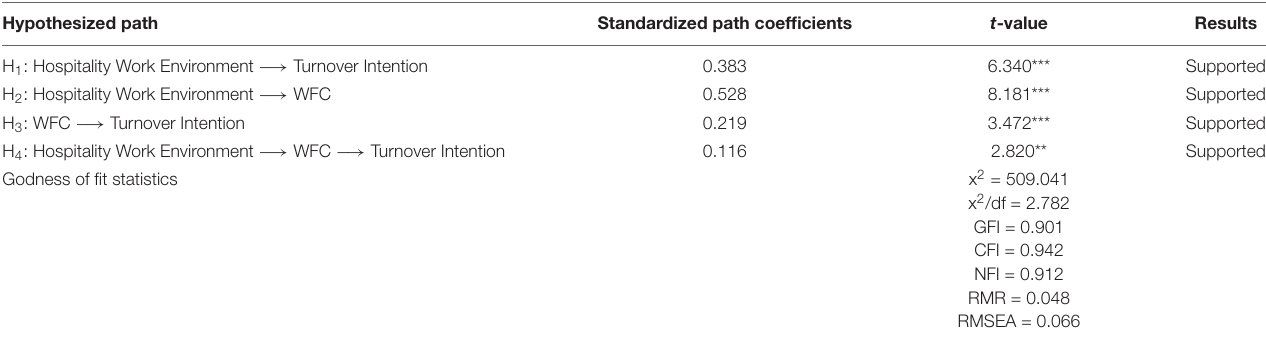
TABLE 3 | Structural parameter